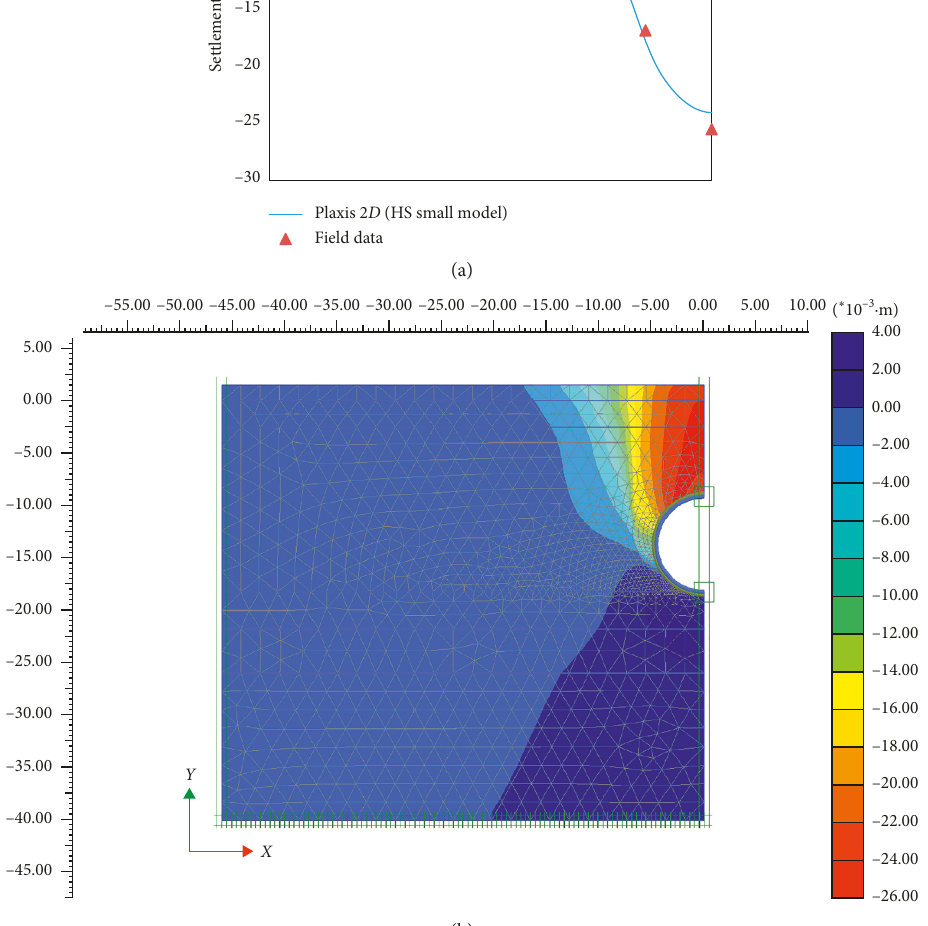
Figure 4: (a) Comparison of PLAXIS 2 D results with field data of Heinenoord tunnel. (b) Detailed displacement contours of Heinenoord Parameter